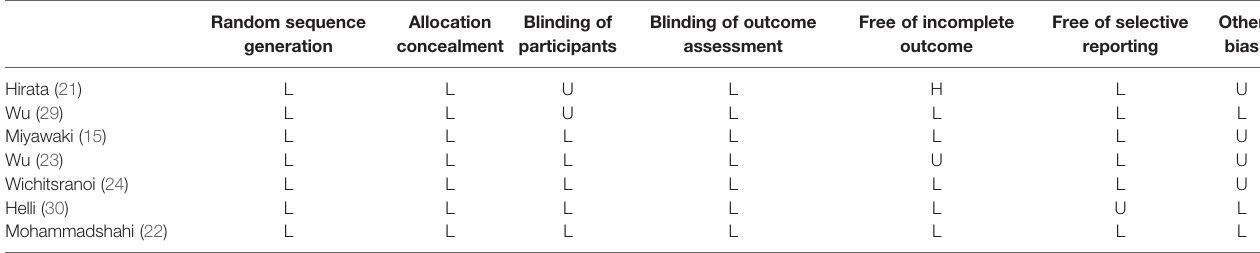
TABLE 3 | Assessment of risk of bias in studies included in the